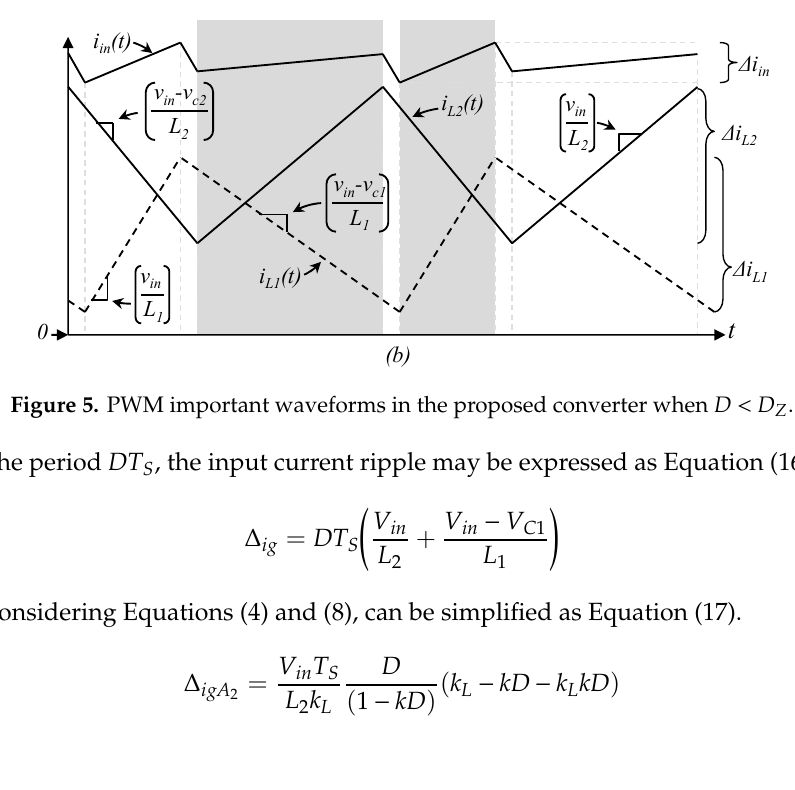
Figure 5. PWM important waveforms in the proposed converter when D < D Z .